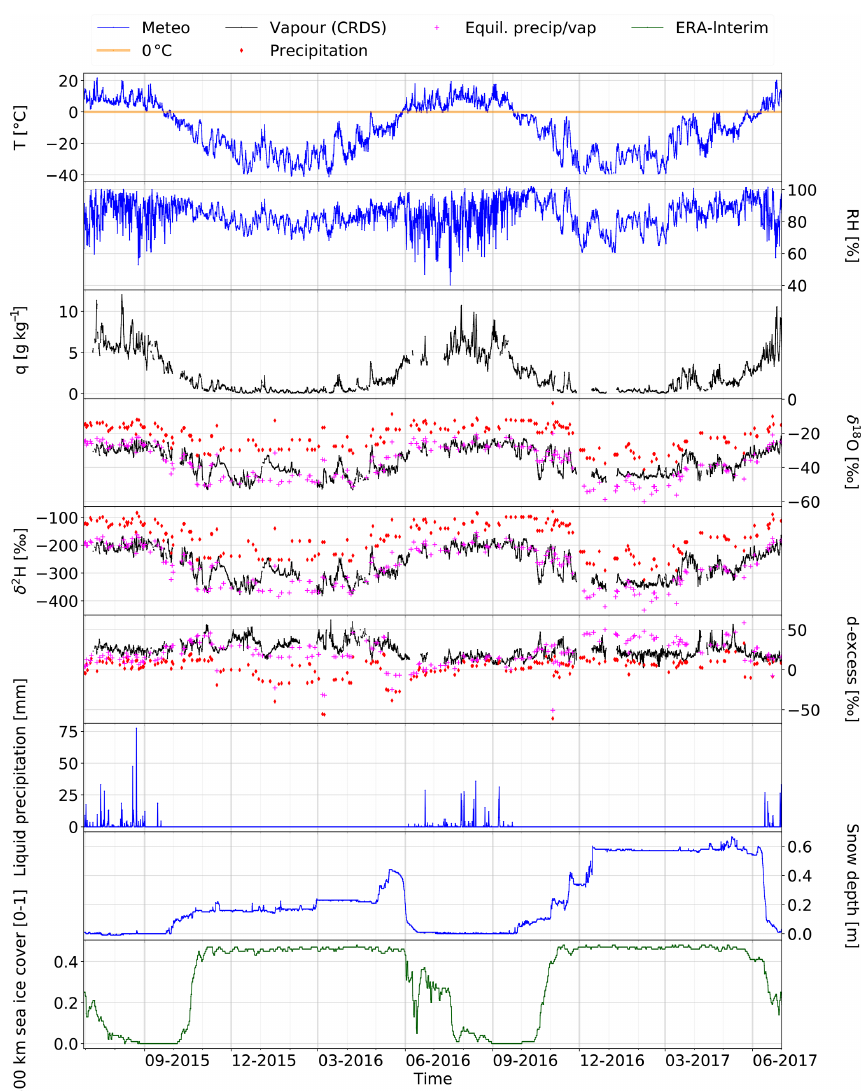
Figure 2. Time series of observations at Samoylov for the period 1 July 2015 to 1 July 2017 for air temperature ( ◦ C), relative humidity (%), specific humidity q (gkg − 1 ), δ 18 O (‰), δ 2 H (‰), d -excess (‰), liquid precipitation amount (mm), depth of the snow cover (m) and fraction of the surrounding 500km area covered by sea ice (from 0 to 1 without unit). Plain lines indicate the continuous parameters, which are displayed in blue for data recorded by the meteorological station, in black for data recorded by the water vapour analyser and in green for data from the ERA-Interim reanalyses database. For the temperature, the plain horizontal orange line indicates the 0 ◦ C value. Red diamonds (purple crosses) represent the discrete isotopic measurements from precipitation samples (the resulting theoretical vapour isotopic composition considering equilibrium fractionation from precipitation). The temporal resolution is 6h for all parameters, except for the precipitation, the resulting theoretical vapour isotopic composition (daily averages of event-based samples) and the daily averaged sea ice